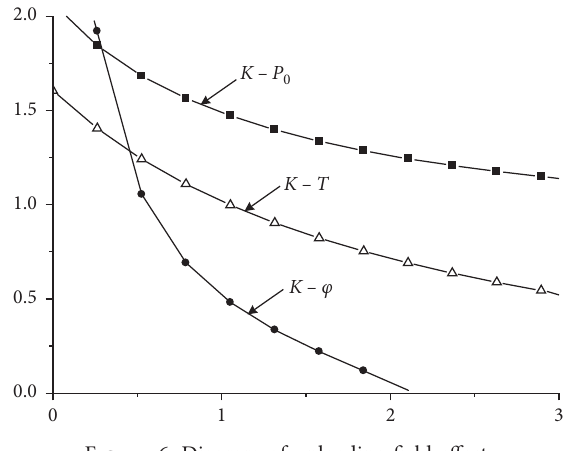
Figure 6: Diagram of unloading field effect.